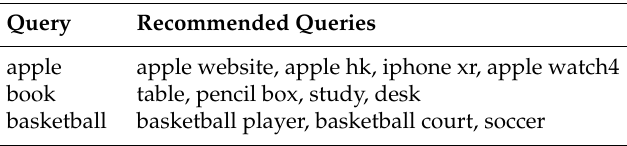
Table 1. Example of query